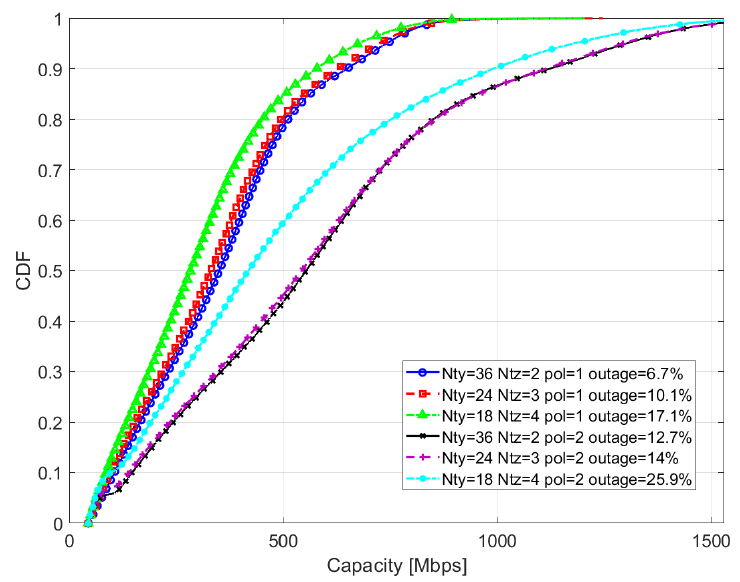
Figure 9. CDF of UT rates for different UPA configurations at the TX, N t = 72, N r = 1, P TX = 47 dBm, traffic density = 2500 users/km 2